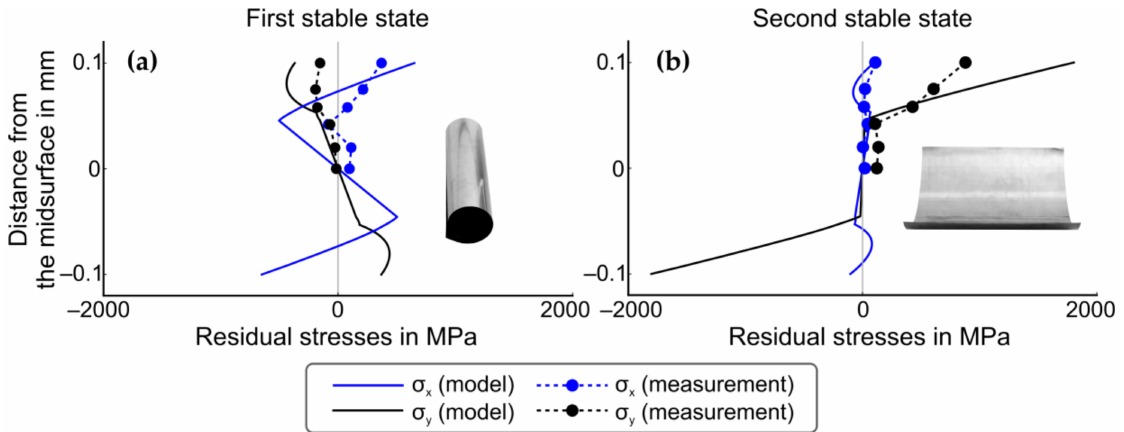
Figure 16. Residual stresses over the shell cross section at first ( a ) and second ( b ) stable state (R 1 = R 2 = 6